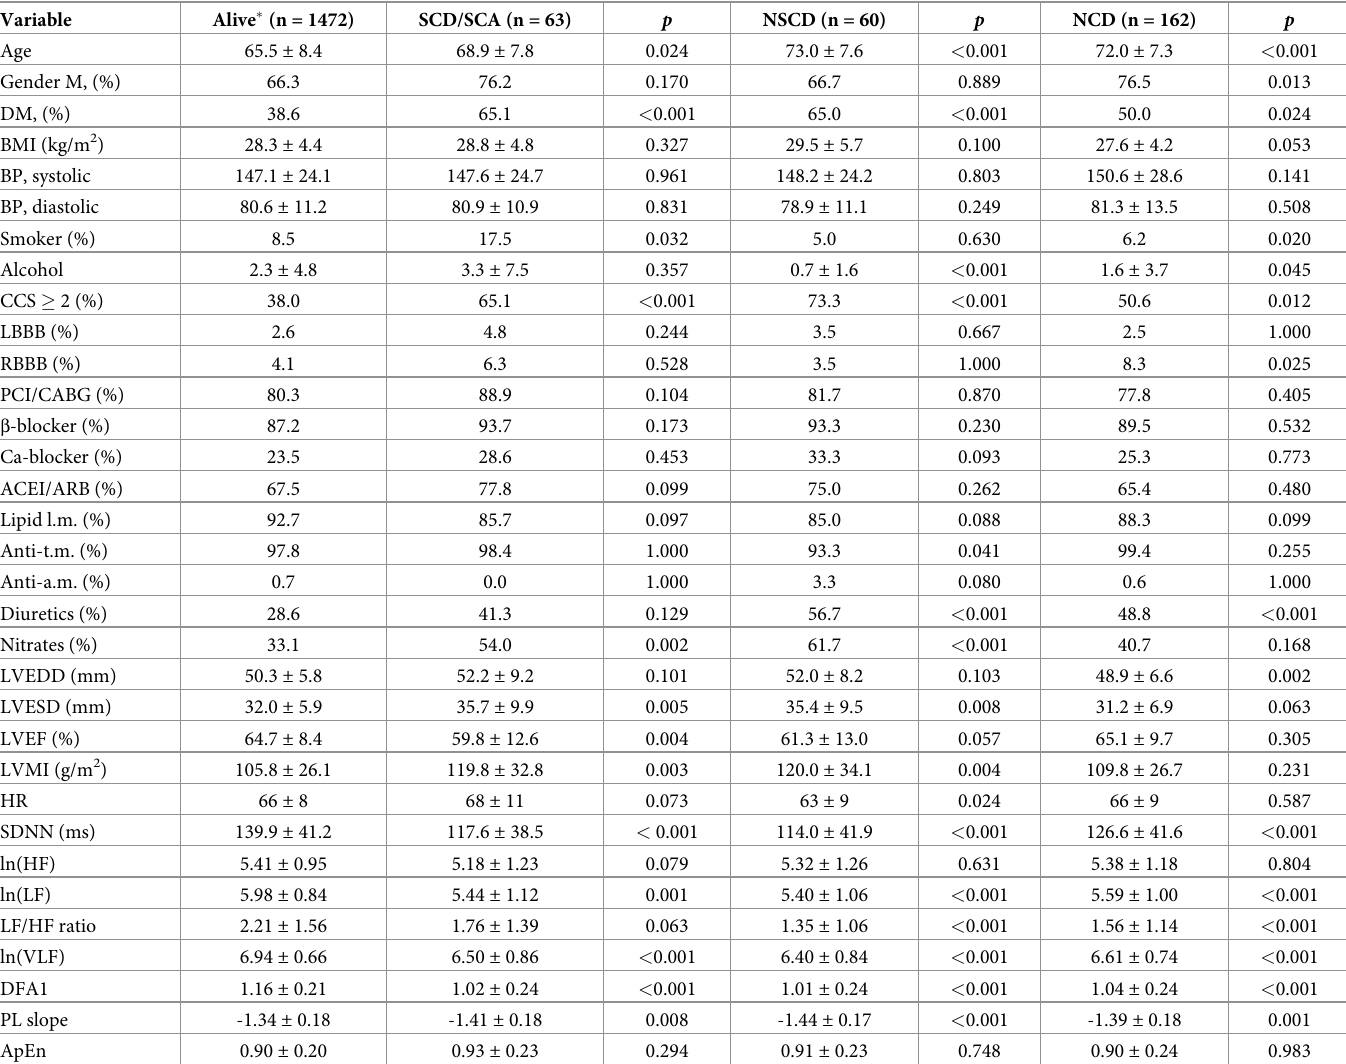
Table 1. Clinical characteristics and heart rate variability parameters in study patients at